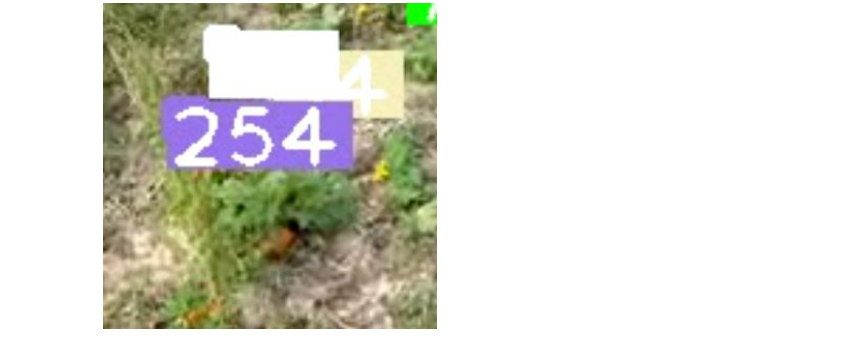
Figure 13. Another pumpkin that is hidden and is not currently detected nor counted.